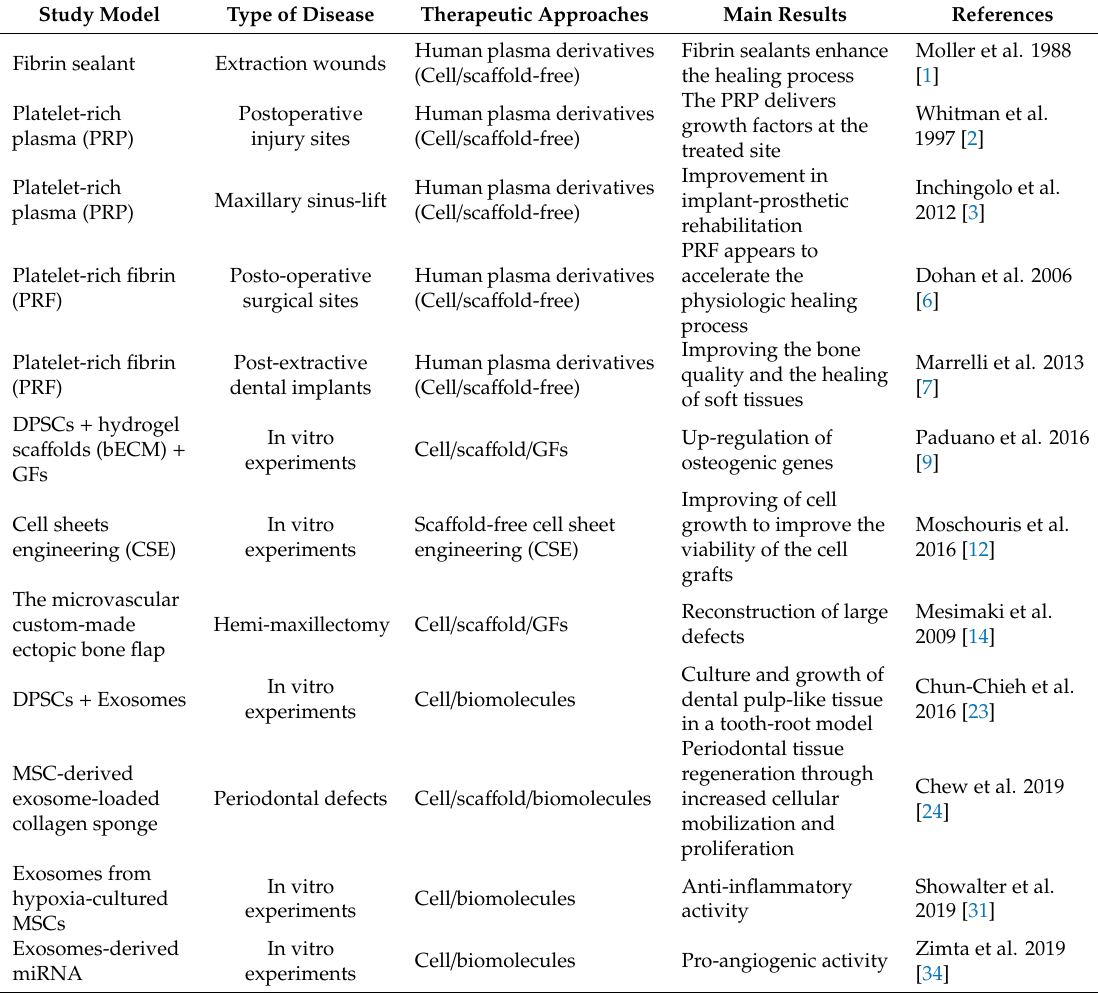
Table 1. Comparative table reporting the main sca ff old-based and sca ff old-free approaches in regenerative